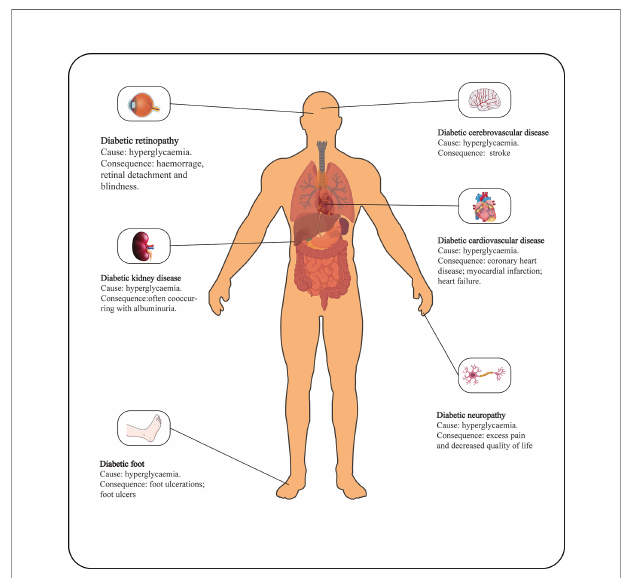
FIGURE 1 | Main causes and consequences of